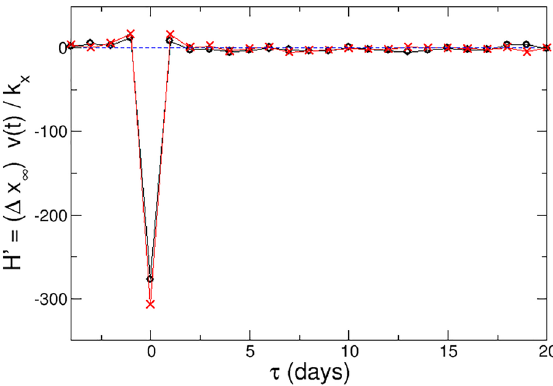
Figure 5. Perturbation energy for positive (black circles) and negative events (red